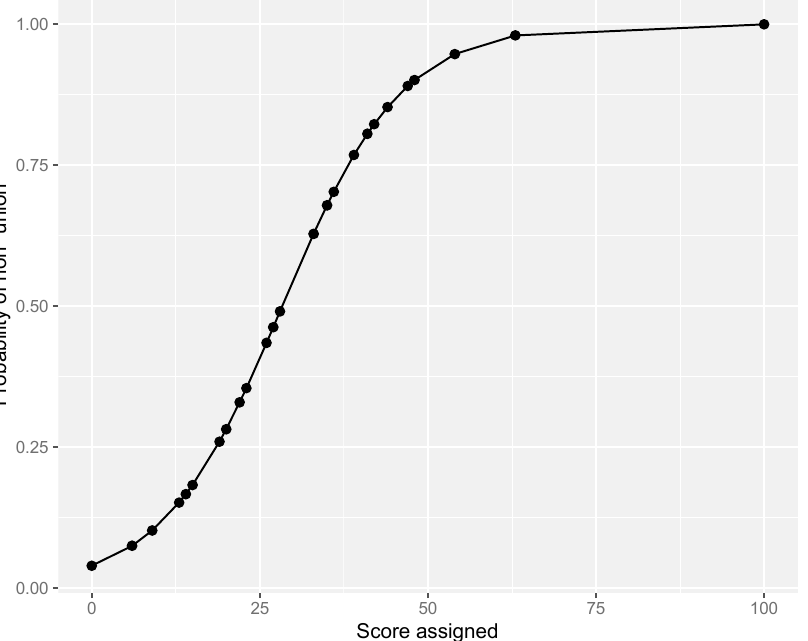
Table 4. Non-union risk score and corresponding probability of non-union.